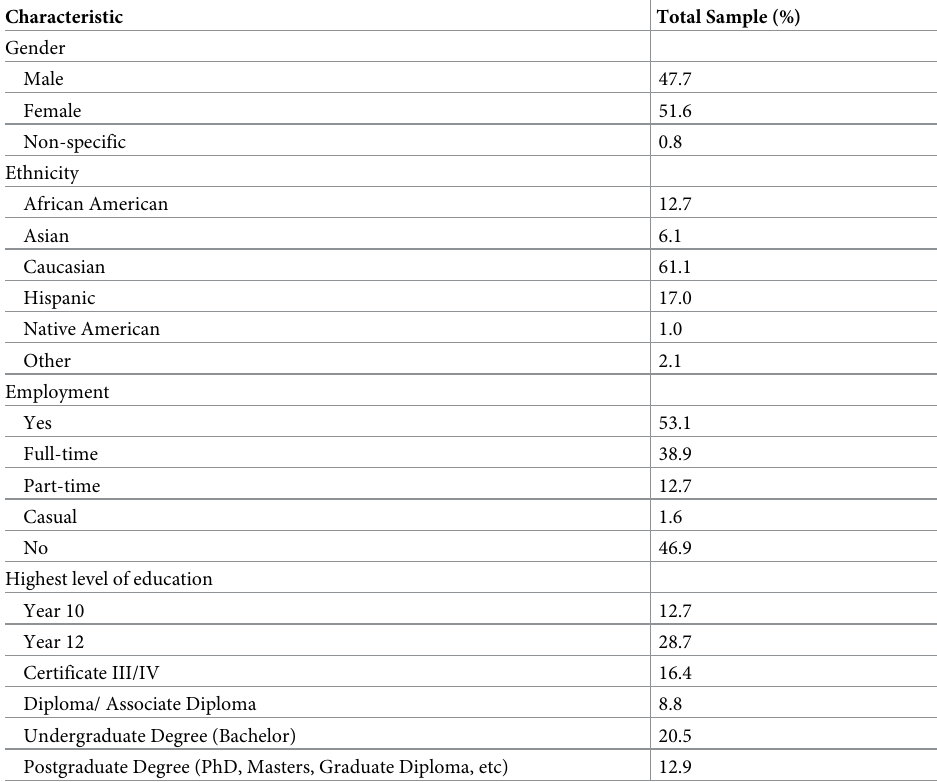
Table 1. Demographic characteristics of the